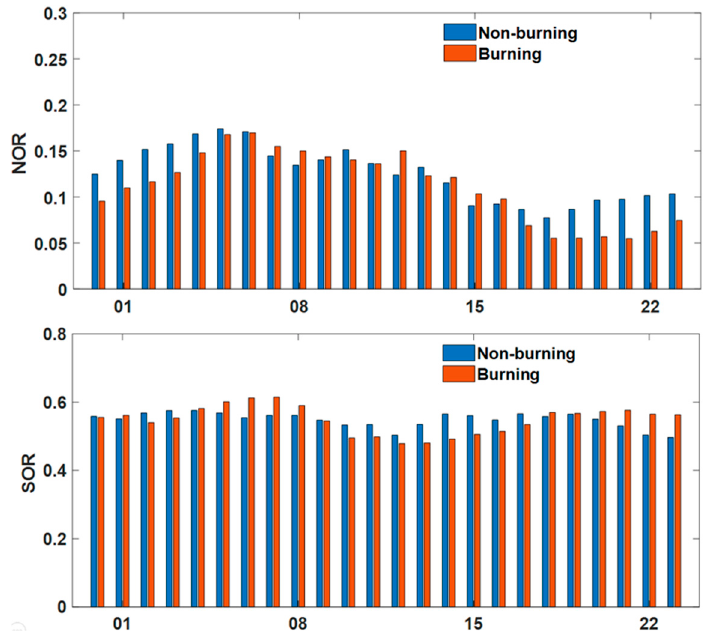
Figure 7. Diurnal variation of SOR and NOR during Burning and Non-burning period.